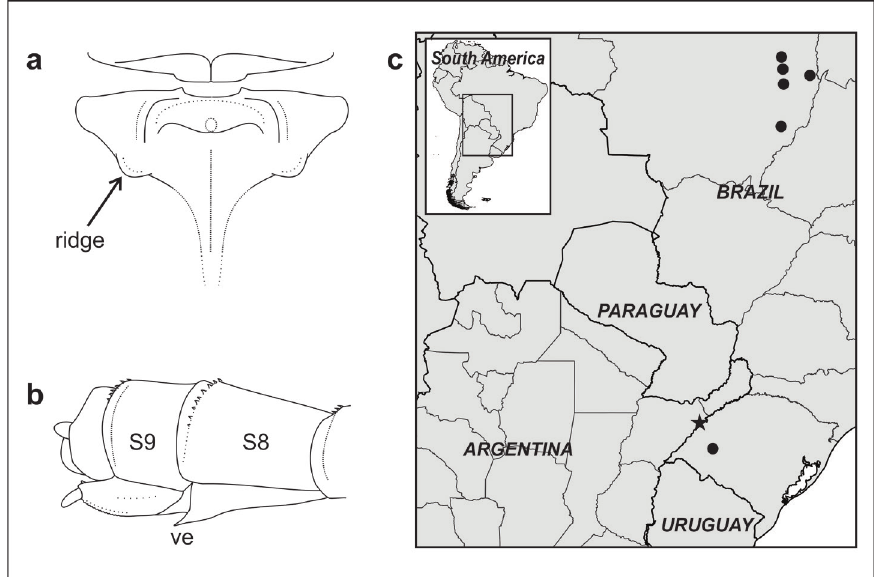
Figure 3. Negragrion sagma sp. n.: a: allotype, modifications of thorax, dorsal view; b: